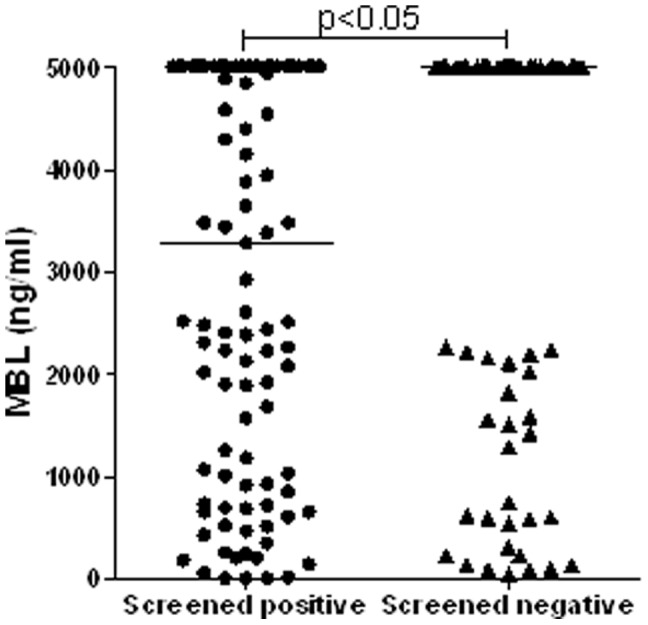
MBL levels in pregnant women with and without autoimmune thyroid disorders.Overall, 103 women tested positively in a screening for AITD performed between the 9th and 12th gestational weeks (grouped together in the left column). They were found to be positive for TPOAb in 86 cases (of these, 12 had TSH elevation, 6 had TSH suppression; the rest was euthyroid). Of the 17 TPOAb-negative ones, 10 had TSH elevation and 7 had TSH suppression. Eighty women were negative for both parameters (right column). Horizontal bars represent median values of serum MBL.